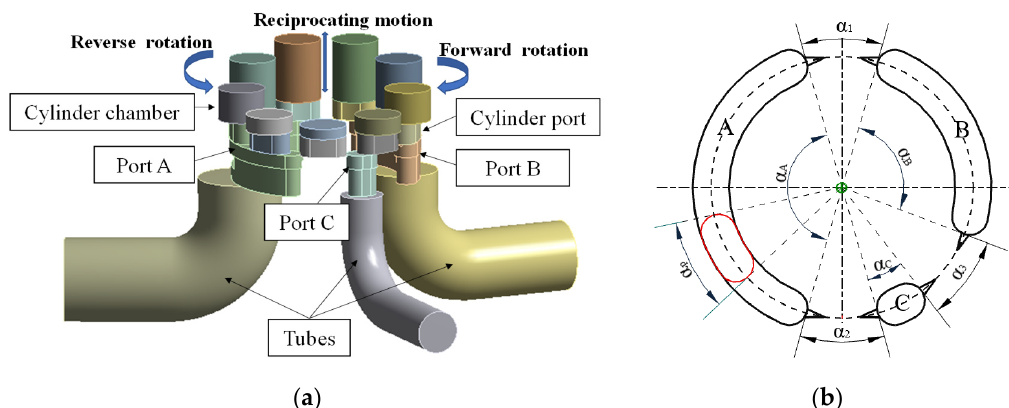
Figure 1. Cylinder and valve plate. Figure 1. cylinder and valve plate.